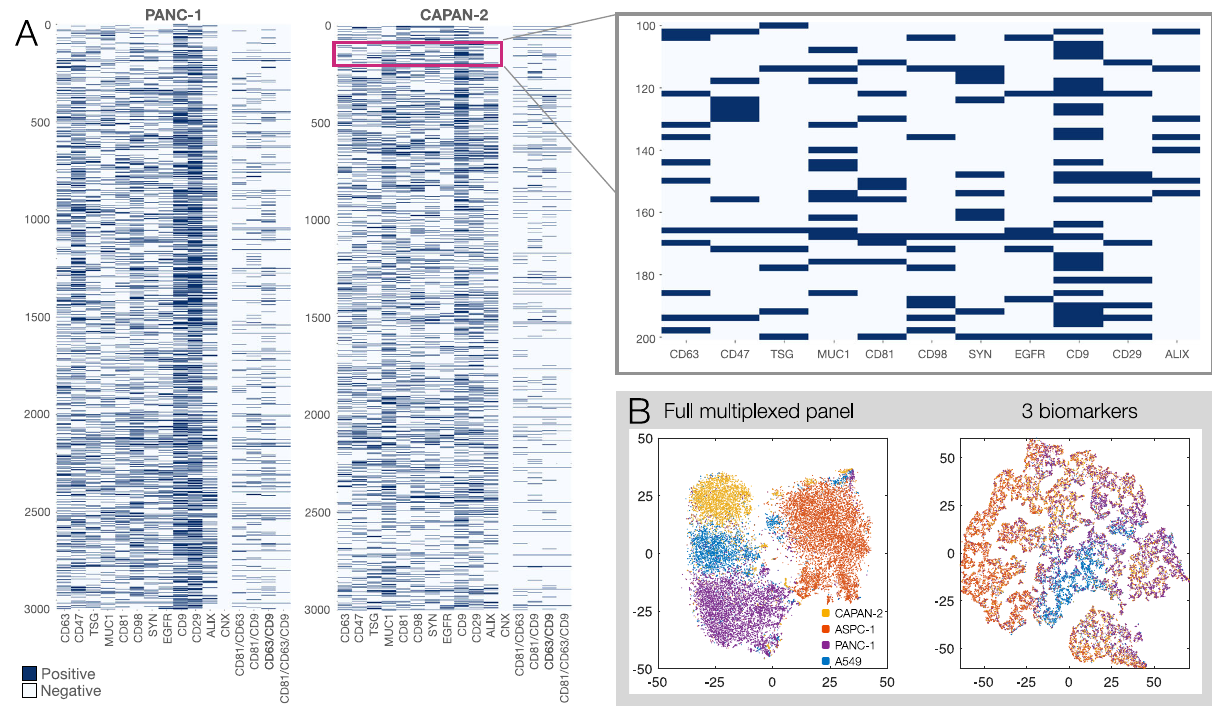
Fig.6|MappingofthousandsofsingleEV.A EachrowrepresentsasingleEVand eachcolumnasingleorcombined tetraspaninbiomarker.PANC-1EVareshownon the left and CAPAN2 EV on the right (for extended pro fi ling of other cell-line derived EV, see Fig. S15). Top right: magni fi ed view shows detailed data on indivi- dualEV.Noclusteringwasappliedintheseexamplestoillustratetheheterogeneity of biomarkers across the large number of single EV. B Dimensionality reduction of